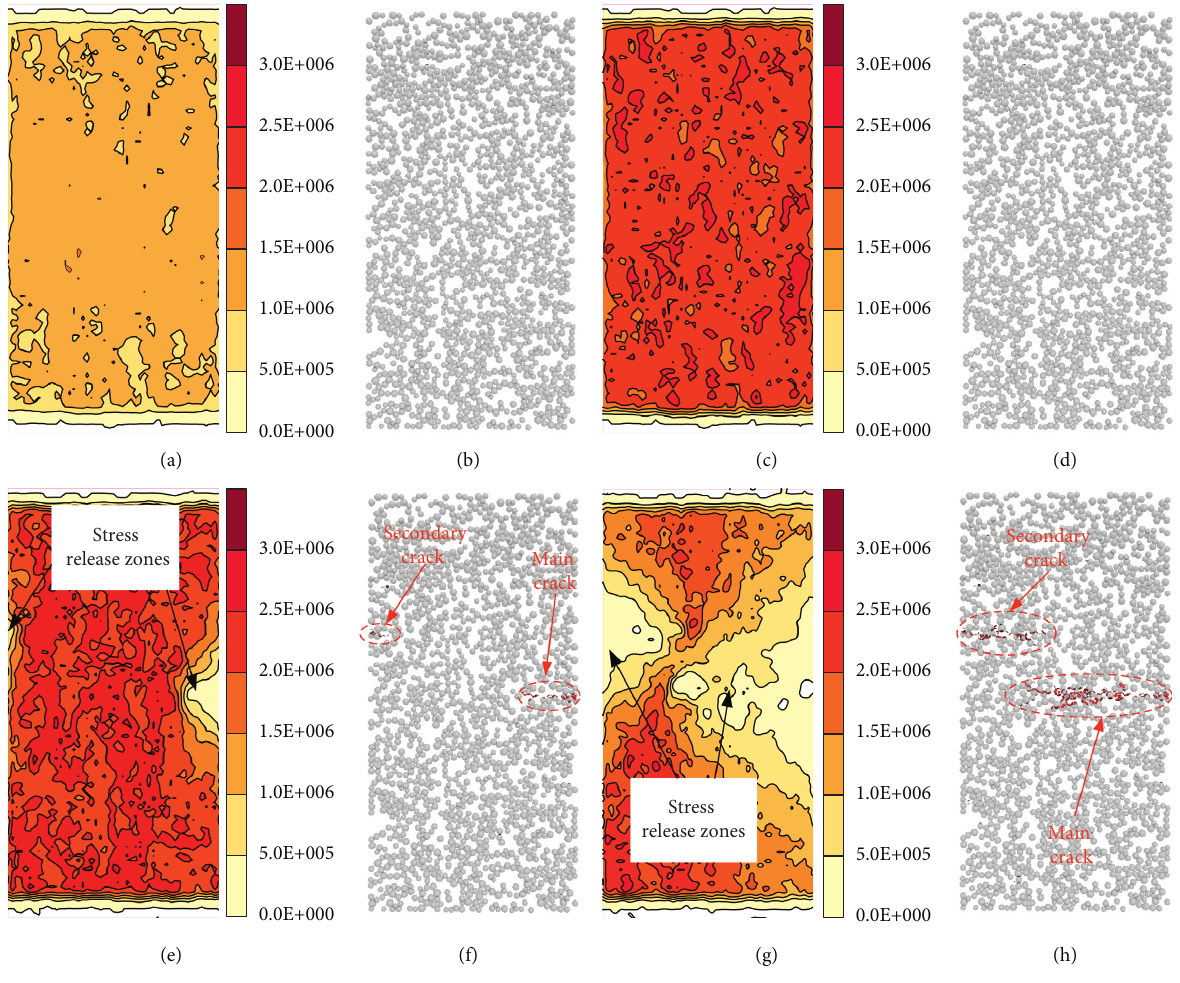
Figure 12: Tensile stresses and crack developments at points